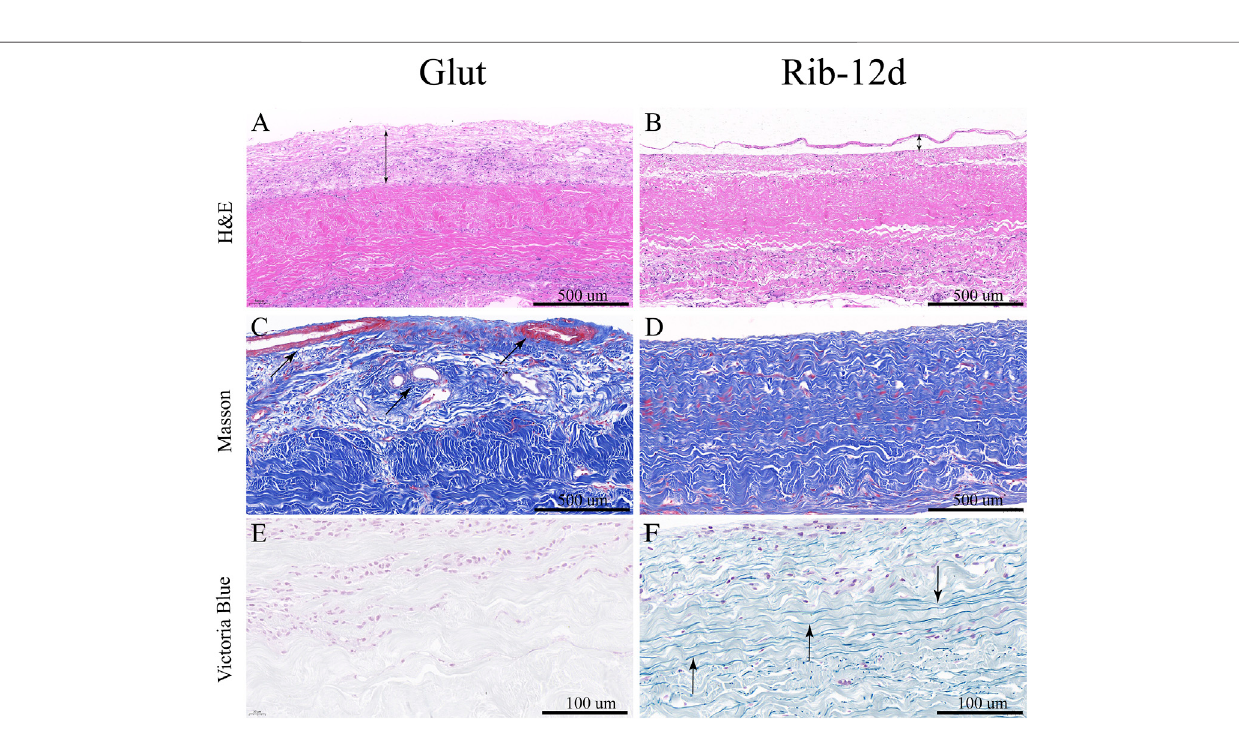
Frontiers in Bioengineering and Biotechnology |